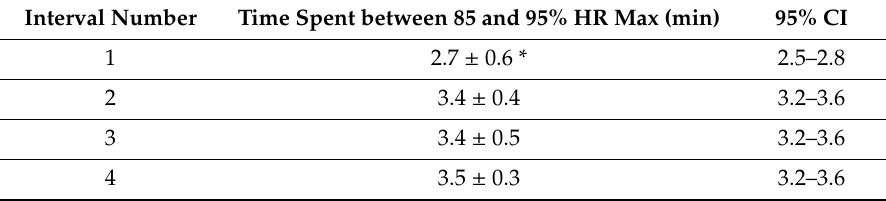
Table 2. Time spent between 85 and 95% HR max during the 4 × 4 regimen (mean ± SD). Interval HR = heart rate; CI = confidence interval; * = p < 0.05 versus all other Time Spent between 85 and 95% HR max (min) Number